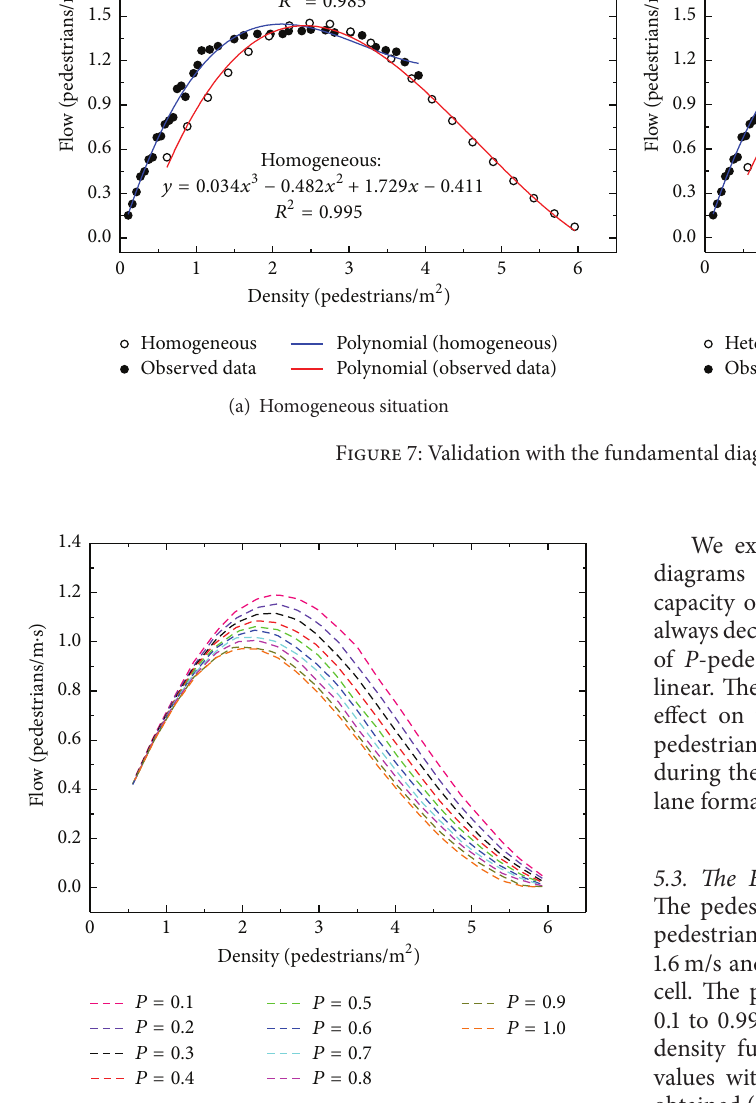
Figure 8: Fundamental diagrams of different proportions of P -